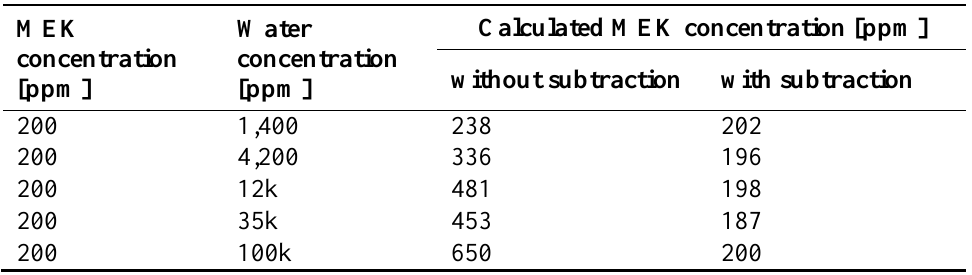
Table 8. Water subtraction experiment: results of the analysis using the water subtracted and not water subtracted